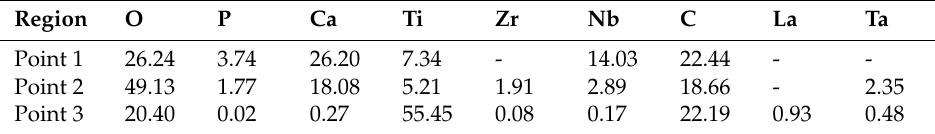
Figure 5. SEM micrographs of sintered nanocomposites in different regions. ( a , b ) Ti-Ta-Nb-Zr/HA; ( c ) 0.5 CNTs; ( d , e ) 0.5 GNFs; ( f ) 0.4 CNTs/0.1 GNFs. Table 3. The EDS results (at. %) for regions A-Ein Figure 5.